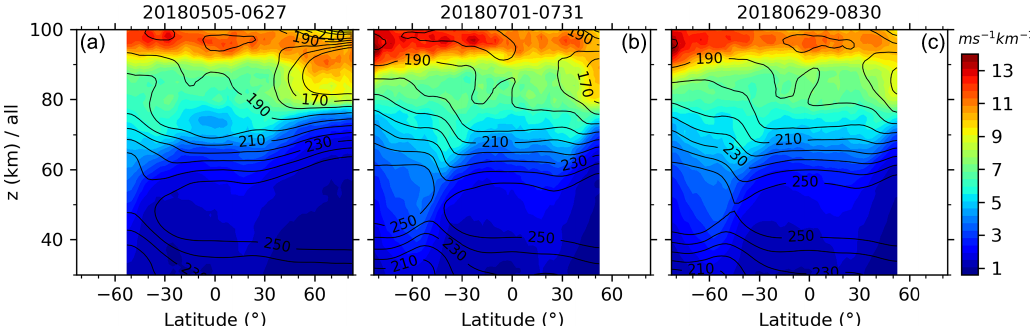
Figure 12. Same as Fig. 4 but for the zonal means of GW-perturbed shears derived under the medium-frequency assumption f/ ˆ ω j = 0.